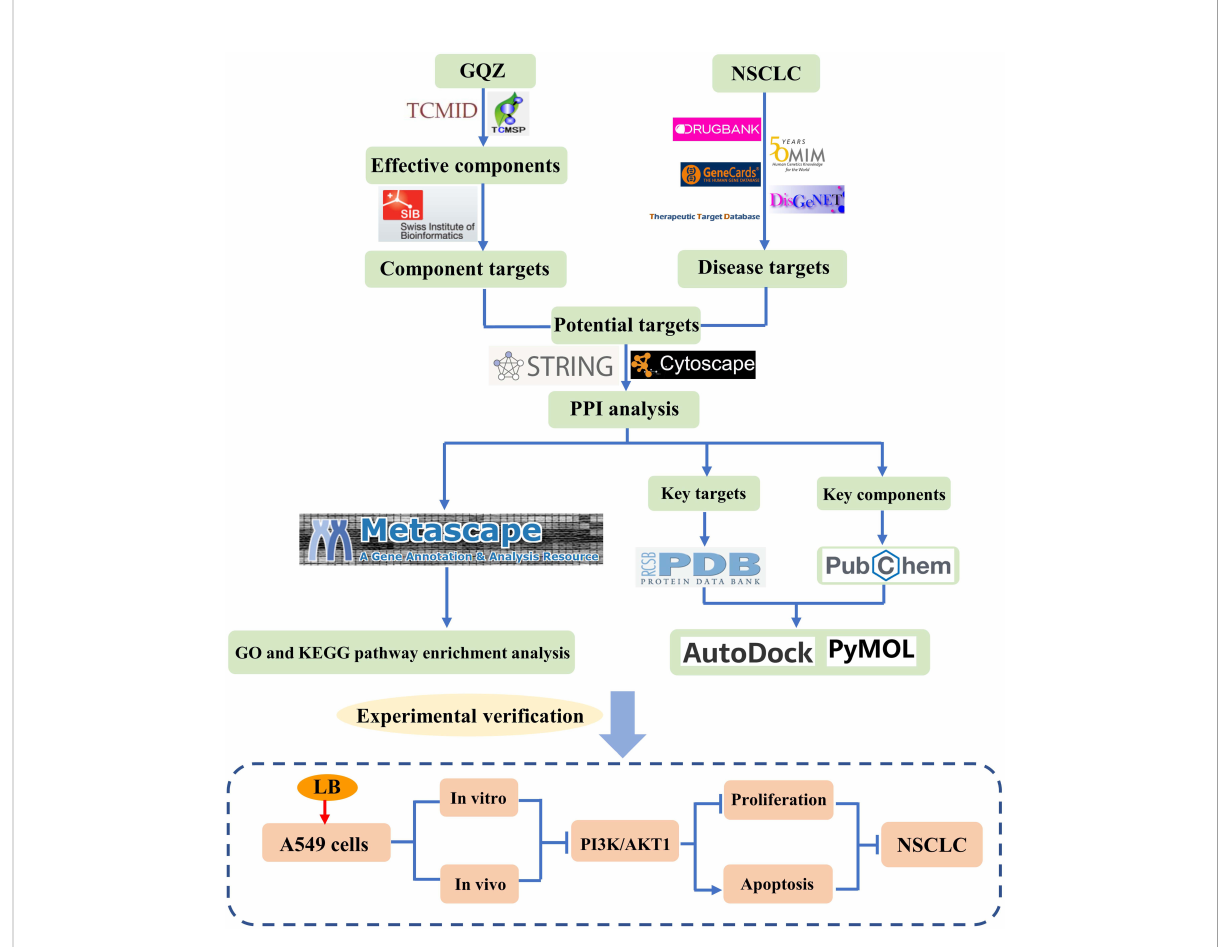
FIGURE 9 Flow chart showing the research performed in this